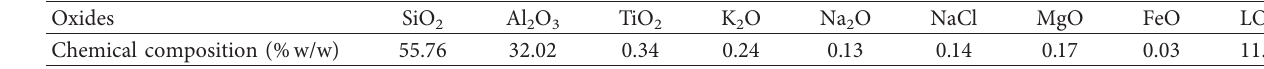
Table 2: Chemical composition of Ethiopian kaolinite.